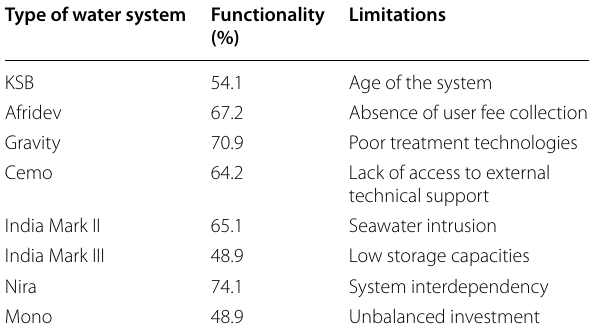
Table 1 Functionality and general limitations of water systems (Foster 2013; Bonsor et al. 2015; Cronk and Bartram 2017; Sweya et al.